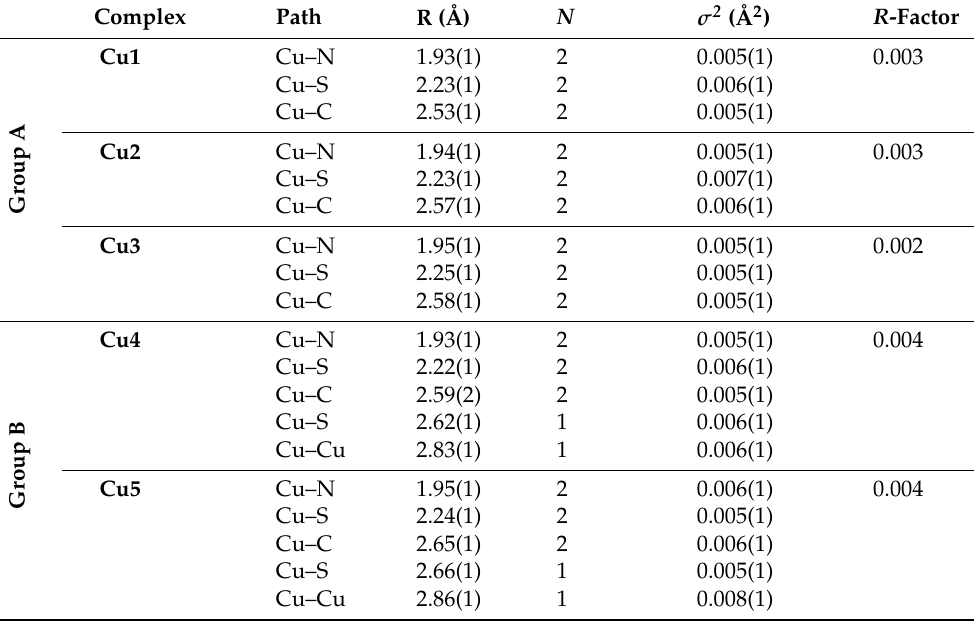
Table 2. The distance from central cation to next atom R, number of atoms n , Debye–Waller factor σ 2 and R -factor of the fit evaluated during the final EXAFS fitting procedure. For clarity, only the main parameters for the closest neighbors are